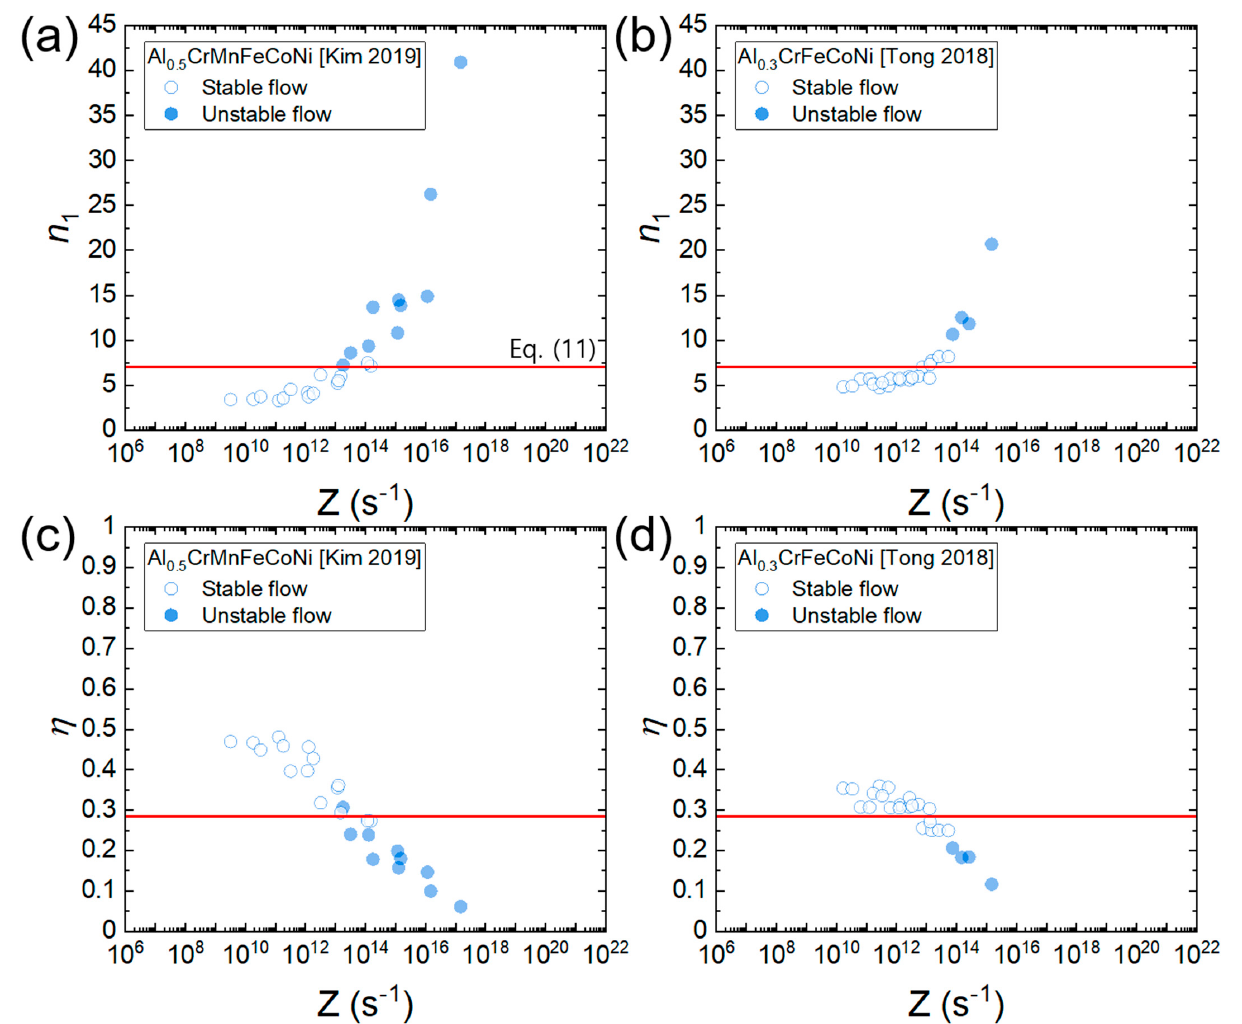
Figure 11. Plot of n 1 and 𝜂 as a function of Z for ( a , c ) Al 0.5 CrMnFeCoNi [34] and ( b , d ) Al 0.3 CrFeCoNi [25]. Open and solid symbols represent the flow stability and instability conditions (determined by Equation (9)), respectively. A red horizontal line represents 𝜂 = 0.285 (Equation (11)).